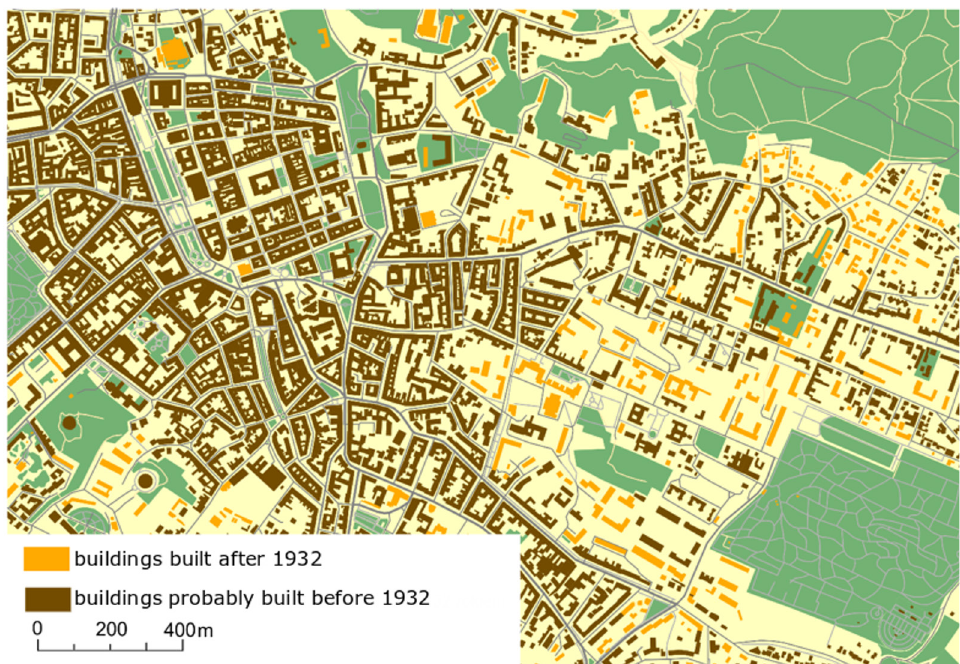
Fig. 4. Buildings erected before 1932 and in the years 1932−2016 (part of the map; own work based on OpenStreetMap vector